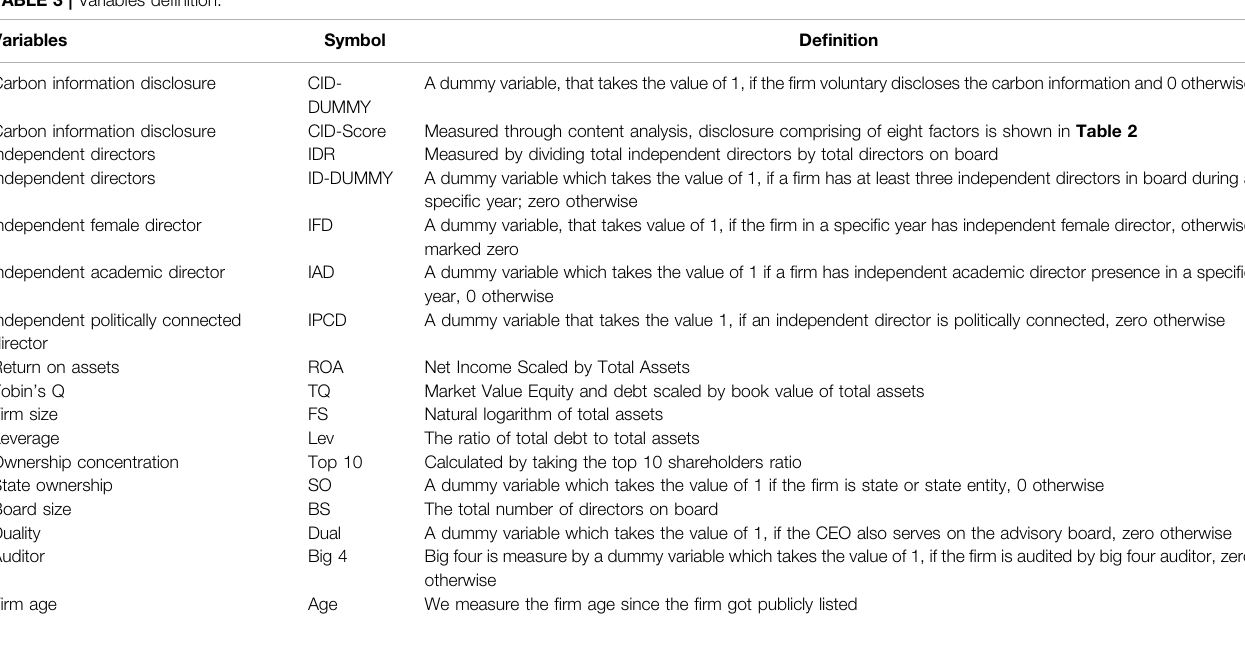
TABLE 3 | Variables de fi